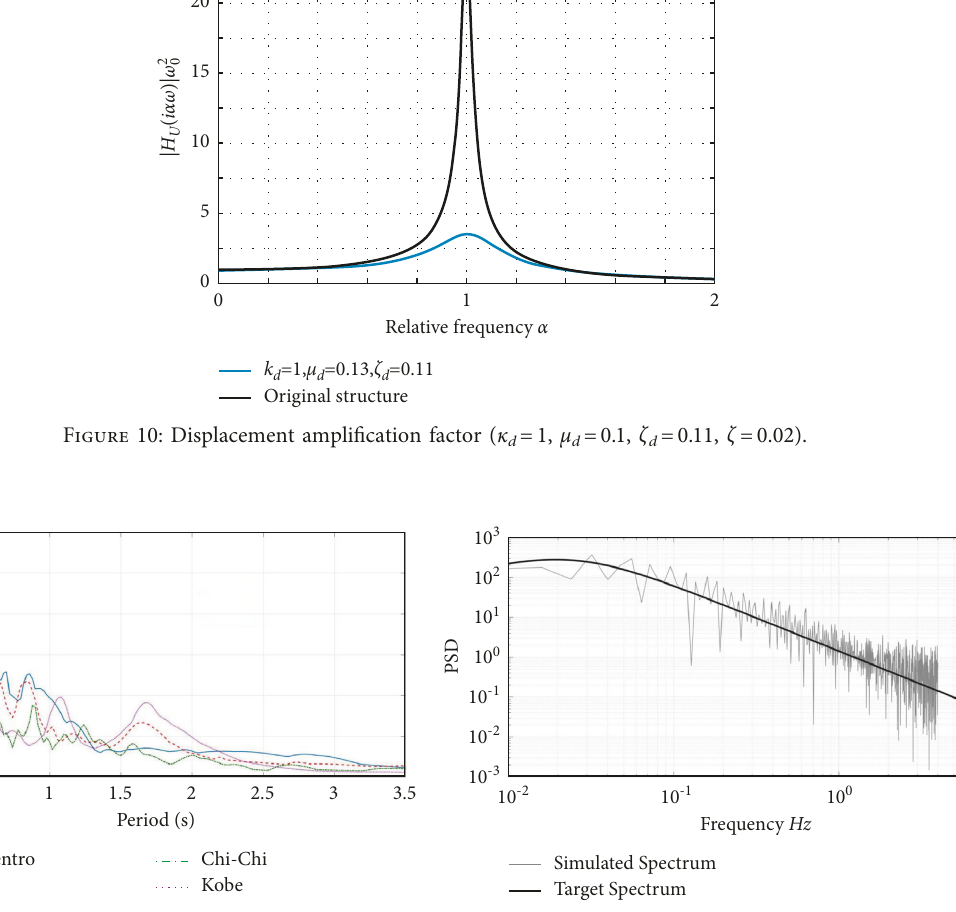
Figure 11: Normalized acceleration spectra of earthquake records and davenport spectrum of fluctuating